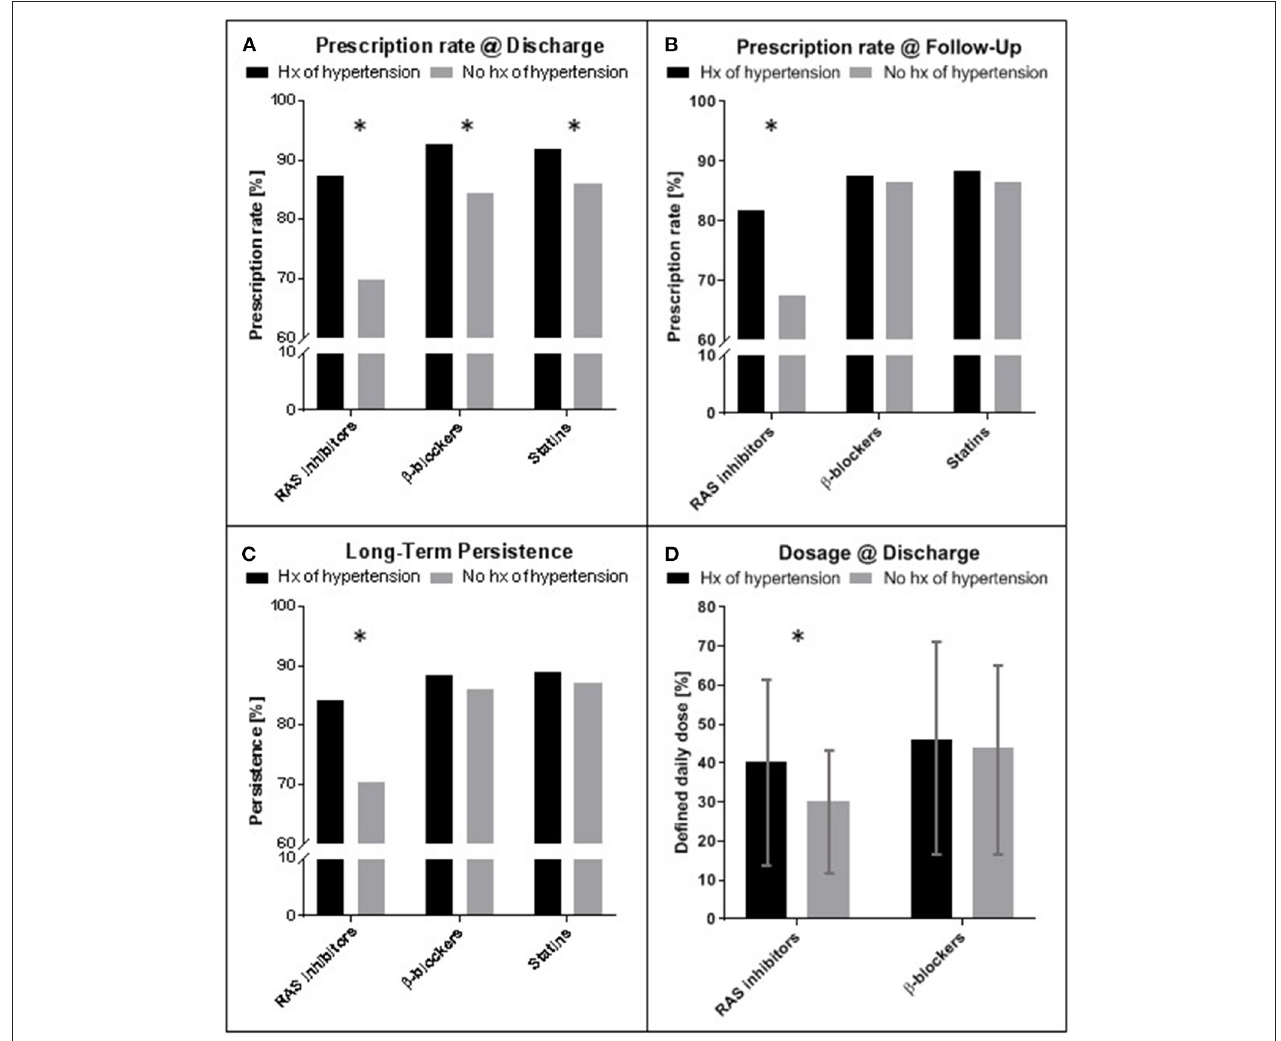
FIGURE 4 | Prescription rate, persistence and dosing of medication for secondary prevention after STEMI. (A) Prescription rates at time of discharge for patients with and without history (hx) of arterial hypertension. (B) Prescription rates at time of last follow up (mean 2.5 years). (C) Long-term persistence measured as percentage of patients with prescription at discharge and follow up of the individual medication. (D) Comparison of dosing for RAS inhibitors and β -blockers at time of discharge. Hx of hypertension: history of hypertension; RAS, Renin Angiotensin system; Mean ± standard deviation. Asterisks indicate significance ( p < 0.05). STEMI—ST-elevation myocardial